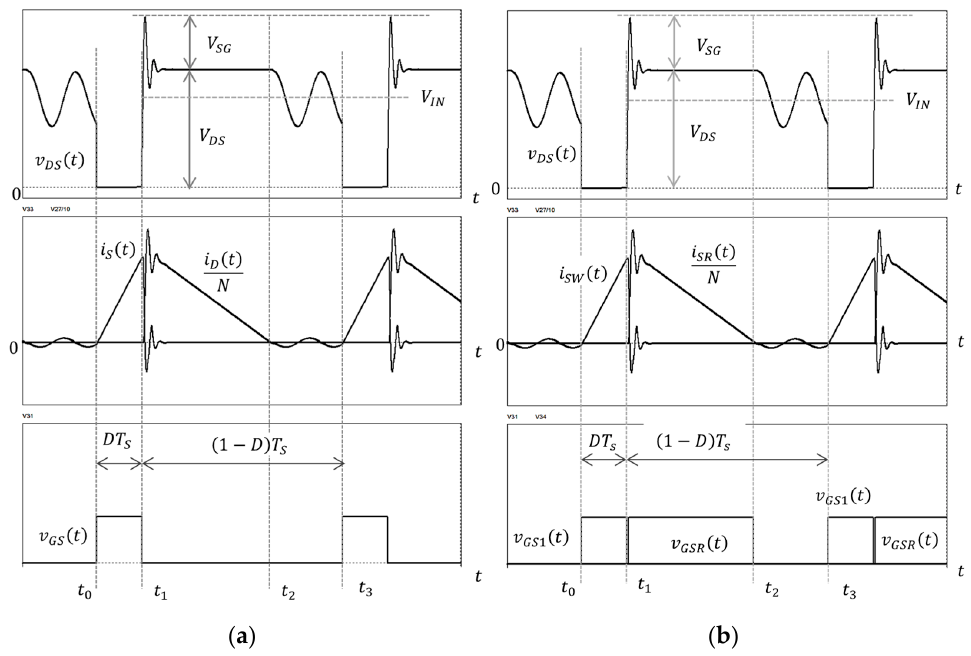
Figure 2. Steady-state operating waveform of QR flyback converter: ( a ) steady-state operating waveform of QR flyback converter with diode rectifier; ( b ) steady-state operating waveform of QR flyback converter with synchronous rectifier.